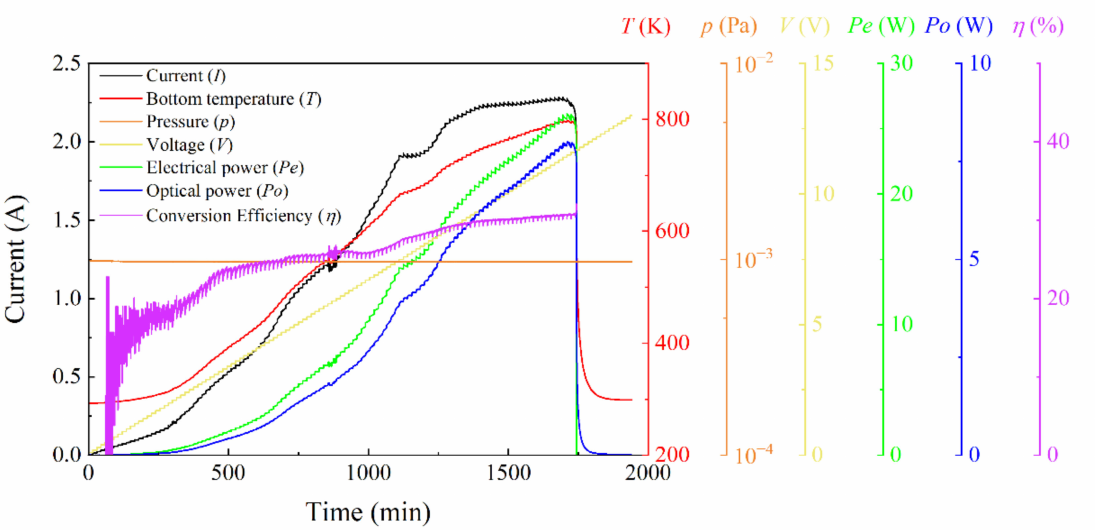
Figure 6. The temporal evolutions of the input voltage ( V ), current ( I ), bottom temperature ( T ), chamber pressure ( p ), electrical power ( P e ), radiated optical power ( P o ), and EOC efficiency ( η ) of an LMM thermal